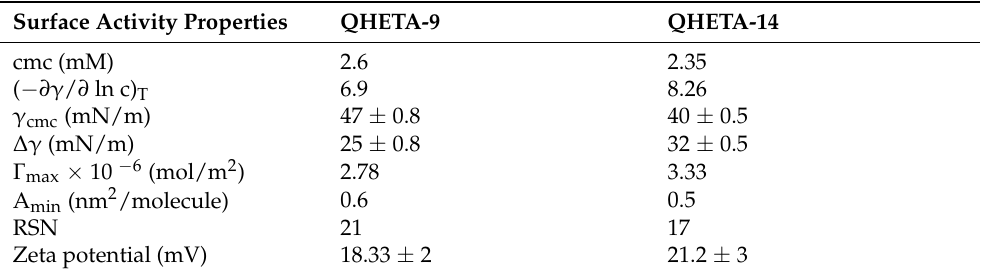
Table 1. Surface activity properties, cmc, RSN and zeta potentials of QHETA-9 and QHETA-14 sur- factants at 25 °C.